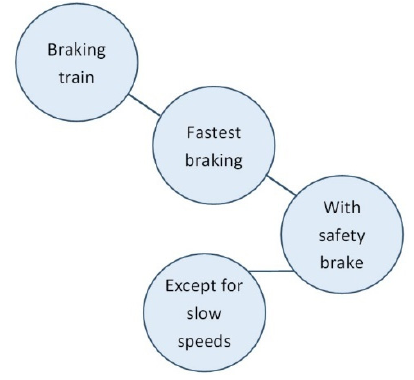
Figure 10. Relevant knowledge comes after the initial answer in the model.